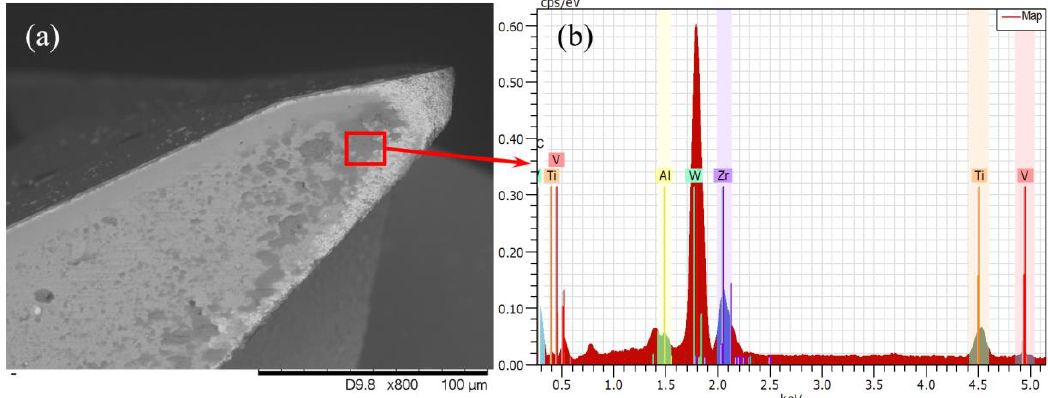
Figure 12. SEM image and energy dispersive spectrometer (EDS) spectra of worn tool. ( a ) SEM image; ( b ) EDS plots.